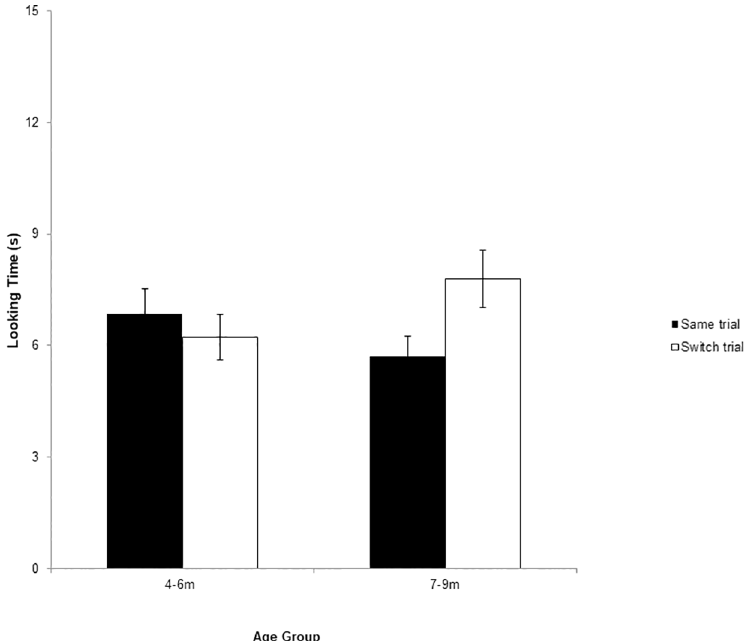
Fig 2. Mean looking times during the same and switch trials for naturally uttered lenis /sa/ and fortis /s (cid:3) a/ sounds among 4- to 6-month-olds and 7- to 9-month-olds. The 7- to 9-month-olds exhibited significantly longer looking times between the switch trials than the same trials. (cid:3) p < .05. Error bars indicate standard errors of the means.